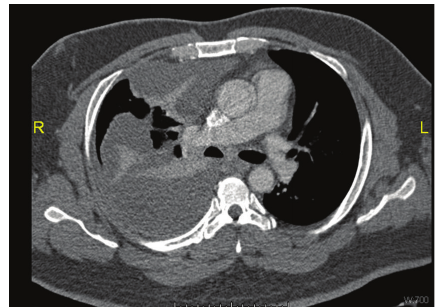
Figure 3: Chest CT showing the encysted pleural e ff